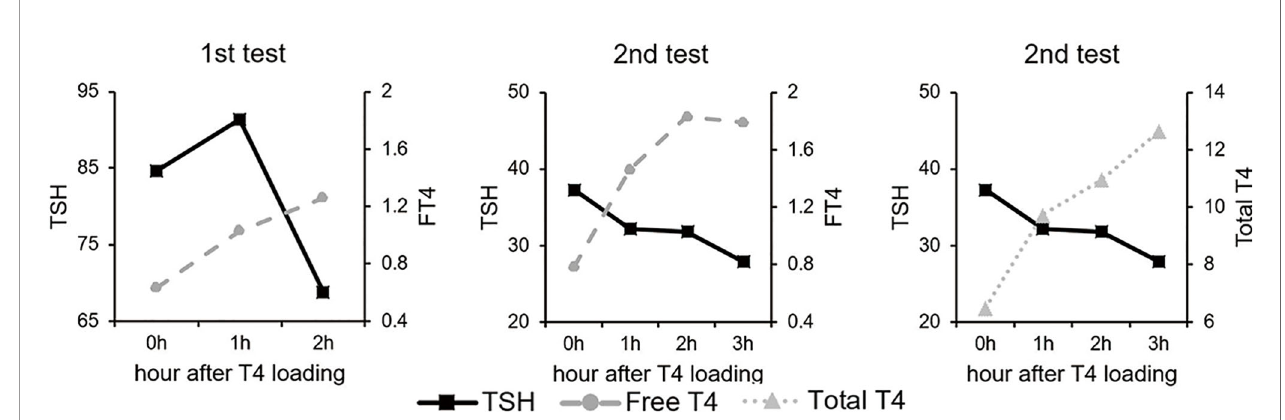
FIGURE 2 | LT4 absorption test. The serum total T4 level increased and TSH level decreased in response to high dose of LT4 ingestion. Absorption rate of LT4 was